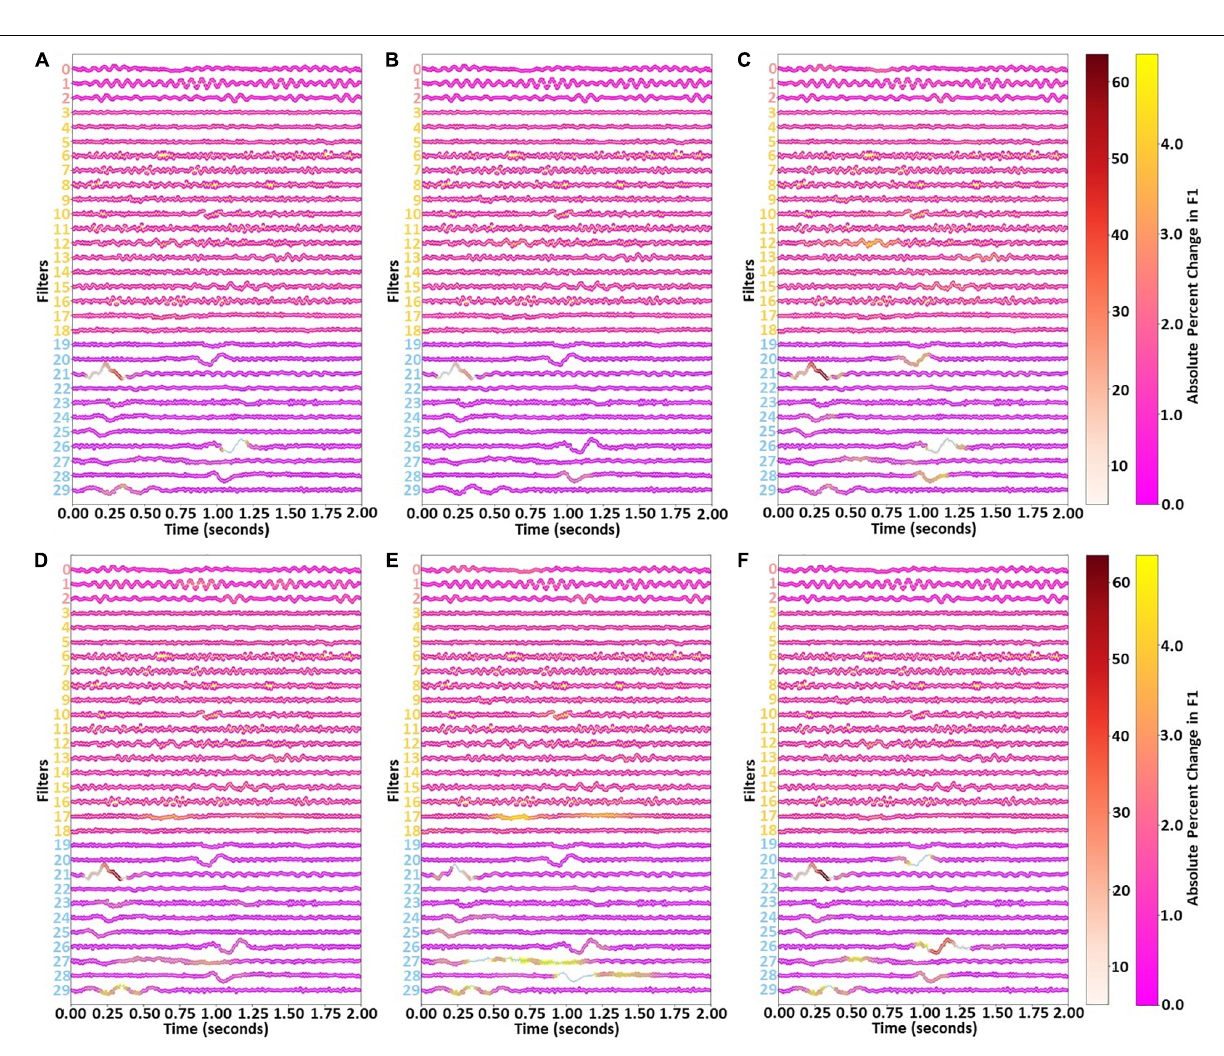
FIGURE 6 | Effects of filter temporal ablation. Panels (A–F) show the effect of ablating each set of 25 filter weights upon the weighted F1-score and Awake, NREM1, NREM2, NREM3, and REM class-specific F1-scores, respectively. Red, yellow, and blue lines show weights for Clusters 0, 1, and 2, respectively. Markers at each time point and the two colormaps indicate the effect of ablating the surrounding 24 time points upon the F1-score. There are two colormaps to enable better visualization of importance for both low and high levels of